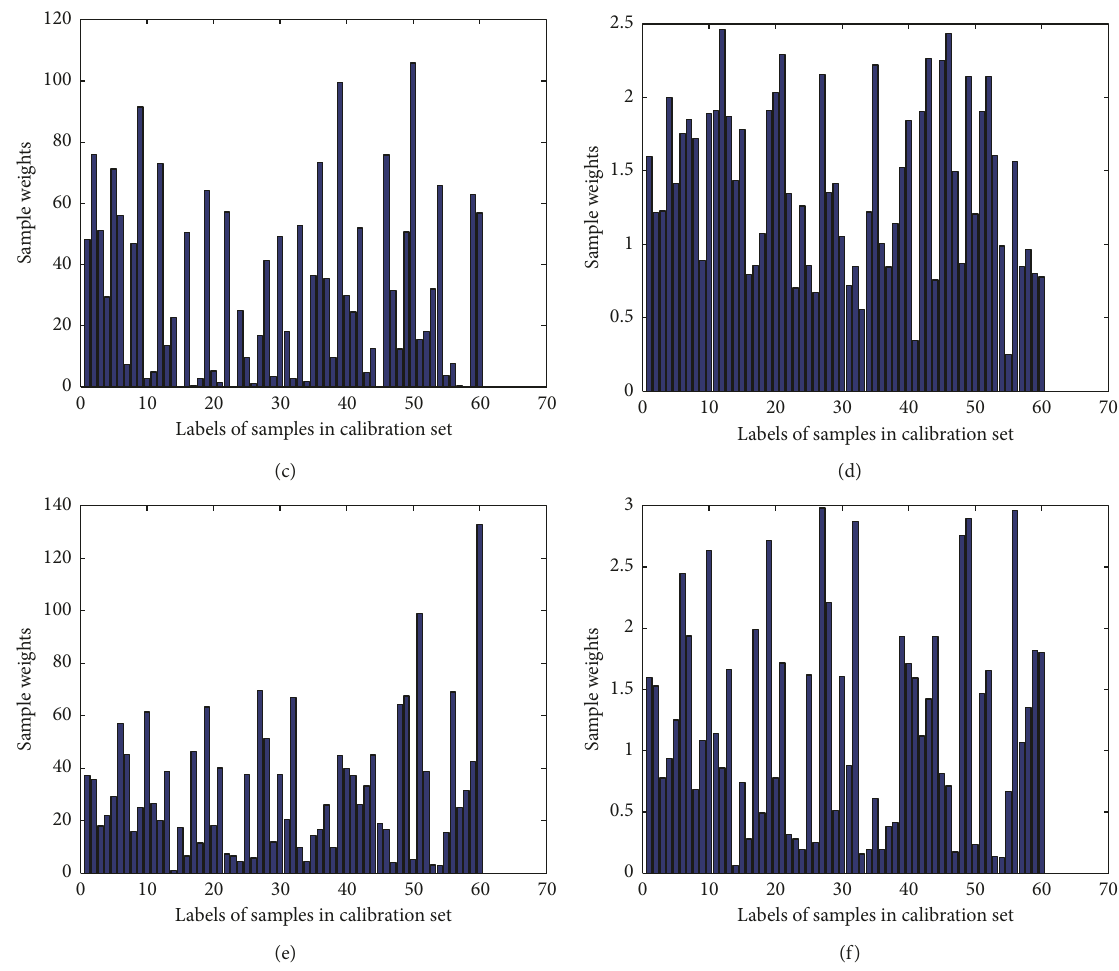
Figure 5: Sample weights after a 70-cycle PSO search for the (a) DPPH scavenging activity characterized by MIR, (b) ABTS scavenging activity characterized by MIR, (c) DPPH scavenging activity characterized by NIR, (d) ABTS scavenging activity characterized by NIR, (e) DPPH scavenging activity characterized by fusion of MIR and NIR, (f) ABTS scavenging activity characterized by fusion of MIR and NIR using OSWLS-SVM. Table 4: The predictions of DPPH scavenging activities by OSWLS-SVM. Prediction